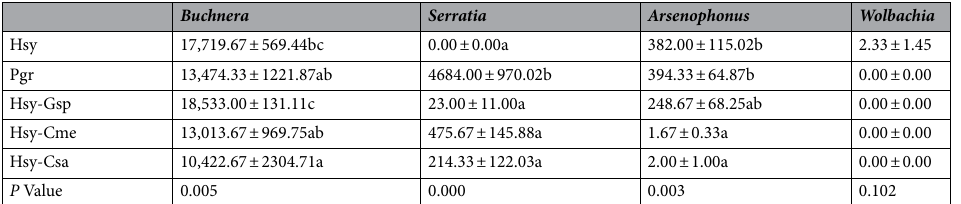
Table 1. Abundance of 4 common endosymbiotic bacteria (mean ± SE) in aphids among Hsy, Pgr, Hsy- Gsp, Hsy-Cme and Hsy-Csa. Different lowercase letters within a row represent significant differences among treatments (P < 0.05).